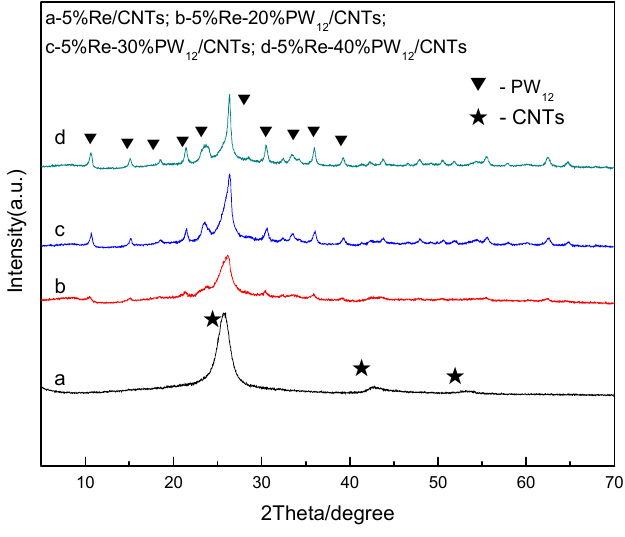
Figure 2. XRD profiles of 5%Re-PW 12 /CNTs with different PW 12 content.